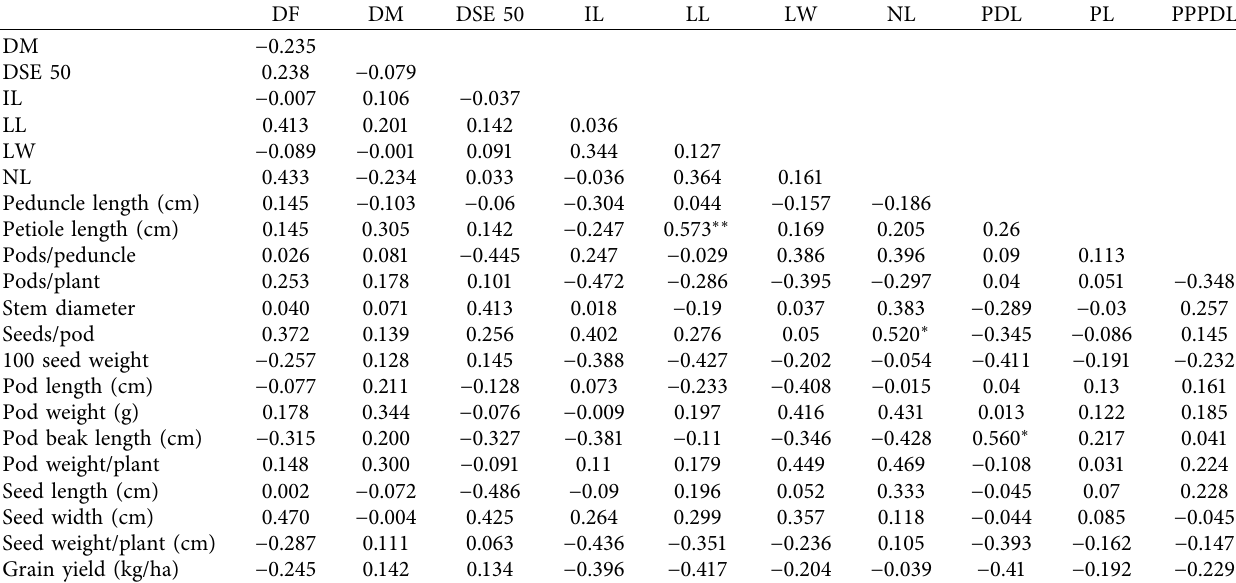
Table 7: Association of morphological traits of African yam bean landraces.